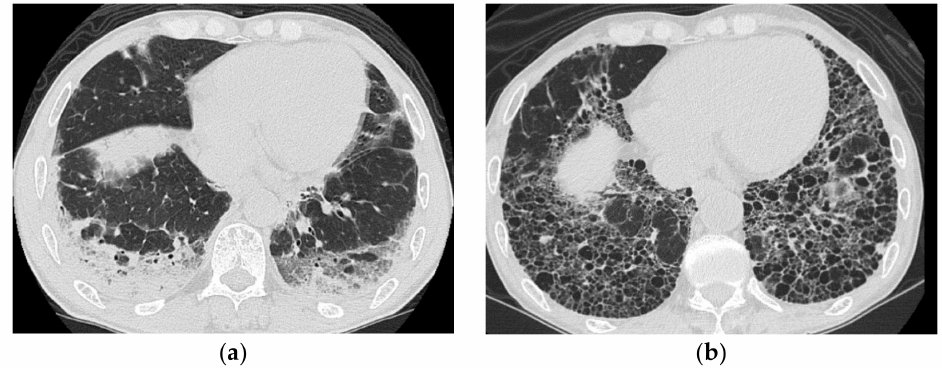
Figure 5. A 51-year-old man with subacute onset interstitial lung disease associated with polymyosi- tis. At the time of initial diagnosis ( a ), there was a subpleural dense consolidation to ground-glass opacification, accompanied by a decreased lower lobe volume. Then, 13 years later ( b ), the lesion became more extensive, and the areas of consolidation had changed as an area with reticular and small cystic lesion, some of which resembled a honeycomb